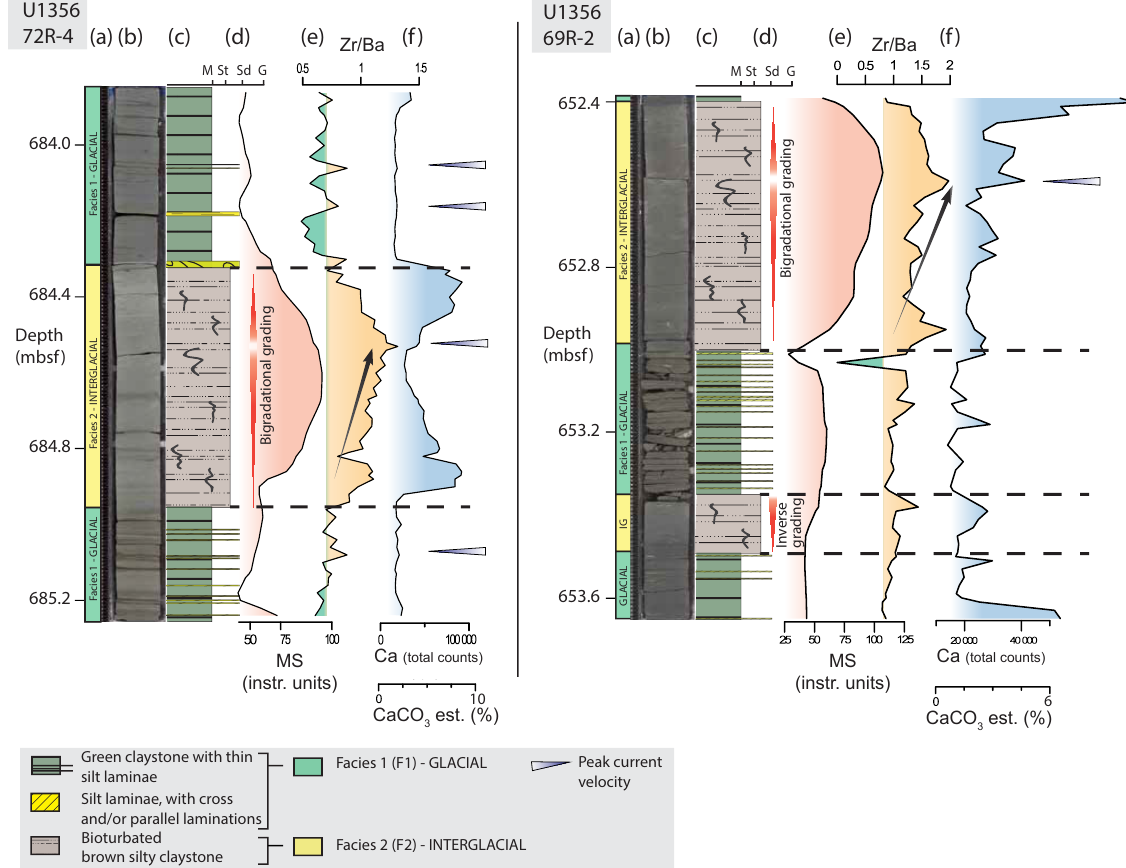
Figure 4. Detailed facies characterization of two representative sections using (a) interpreted Facies F1 and F2; a high-resolution digital image of the core sections (b) , facies log (c) , magnetic susceptibility (MS) (d) , XRF Zr / Ba ratio (e) , and XRF calcium counts (f)